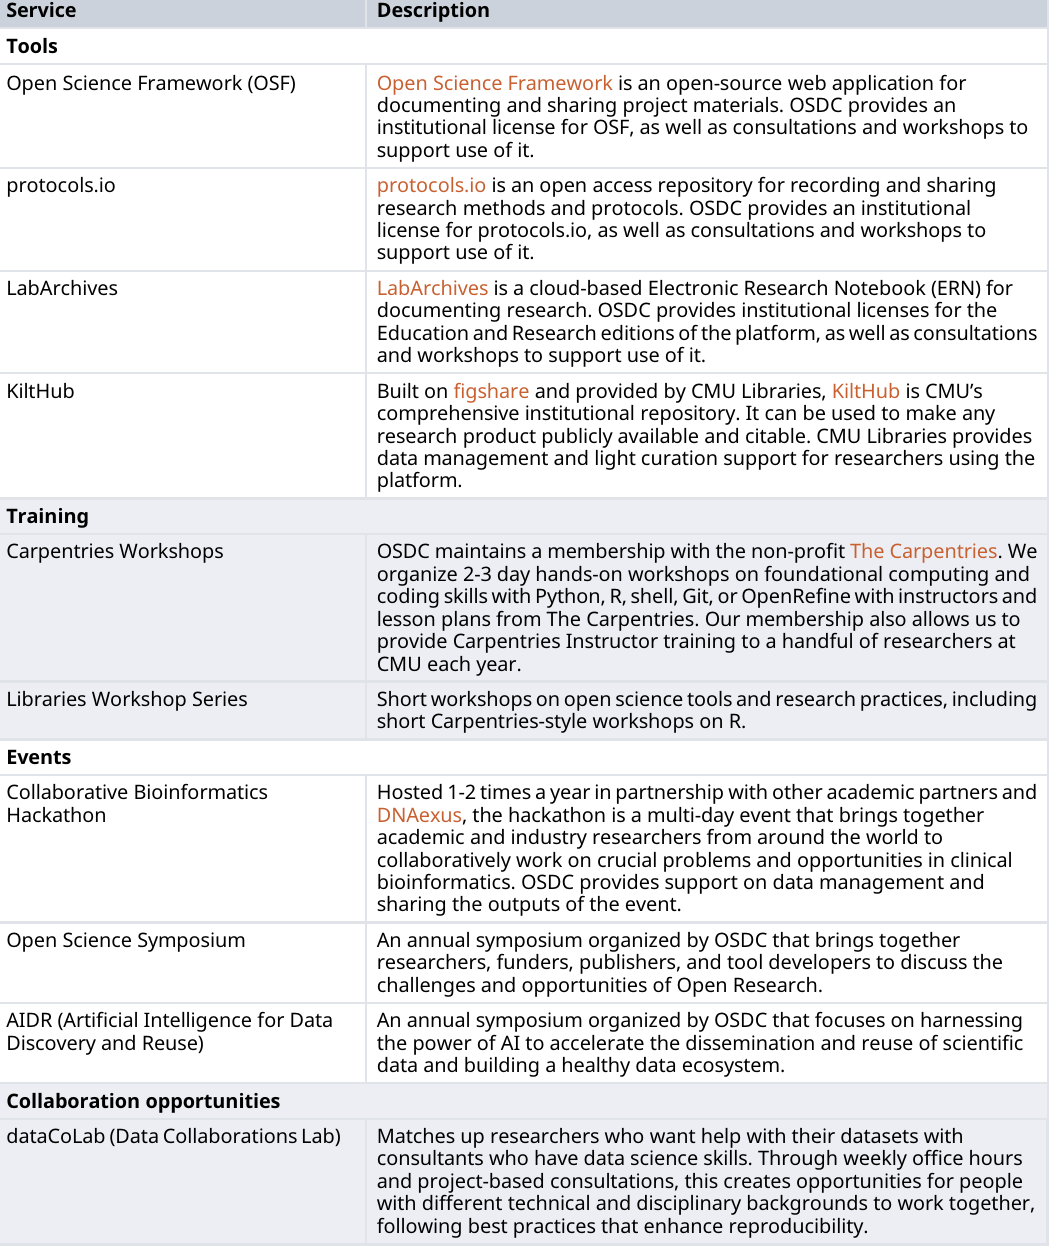
Table 1. Brief description of Open Science and Data Collaborations (OSDC) program components. Services in the OSDC program are composed of four major categories: tools, training, events, and collaboration.